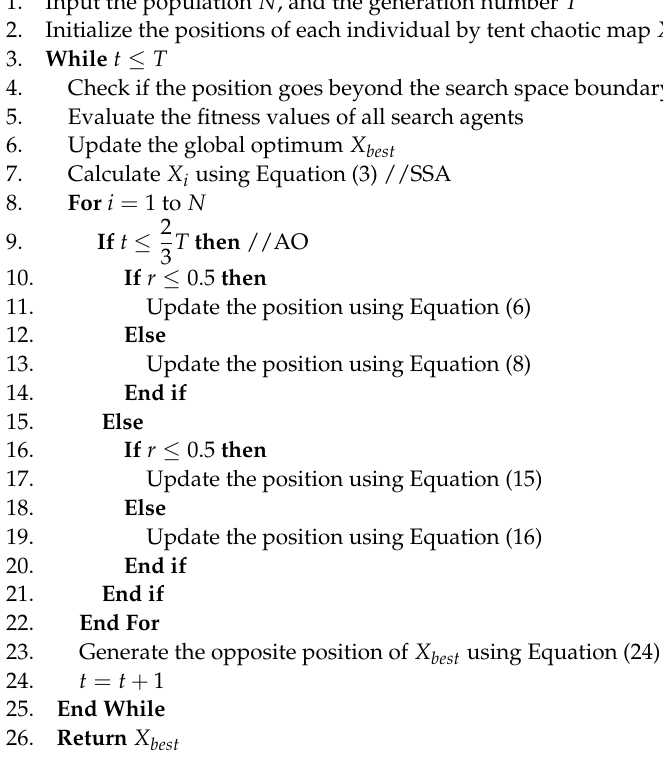
Algorithm 1 Pseudo-code of the proposed IHSSAO algorithm